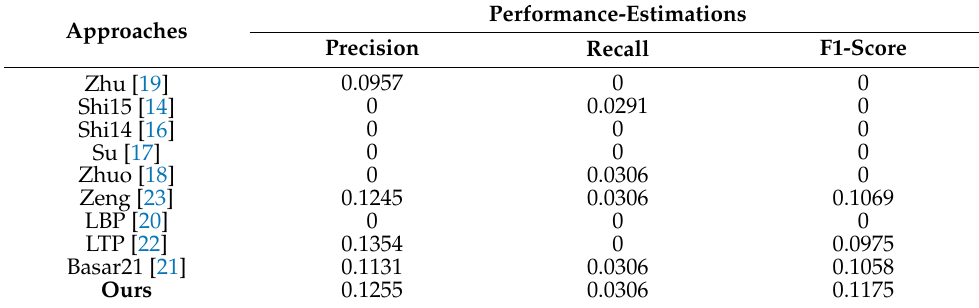
Table 7. Evaluation results of average ( N ϑ ).